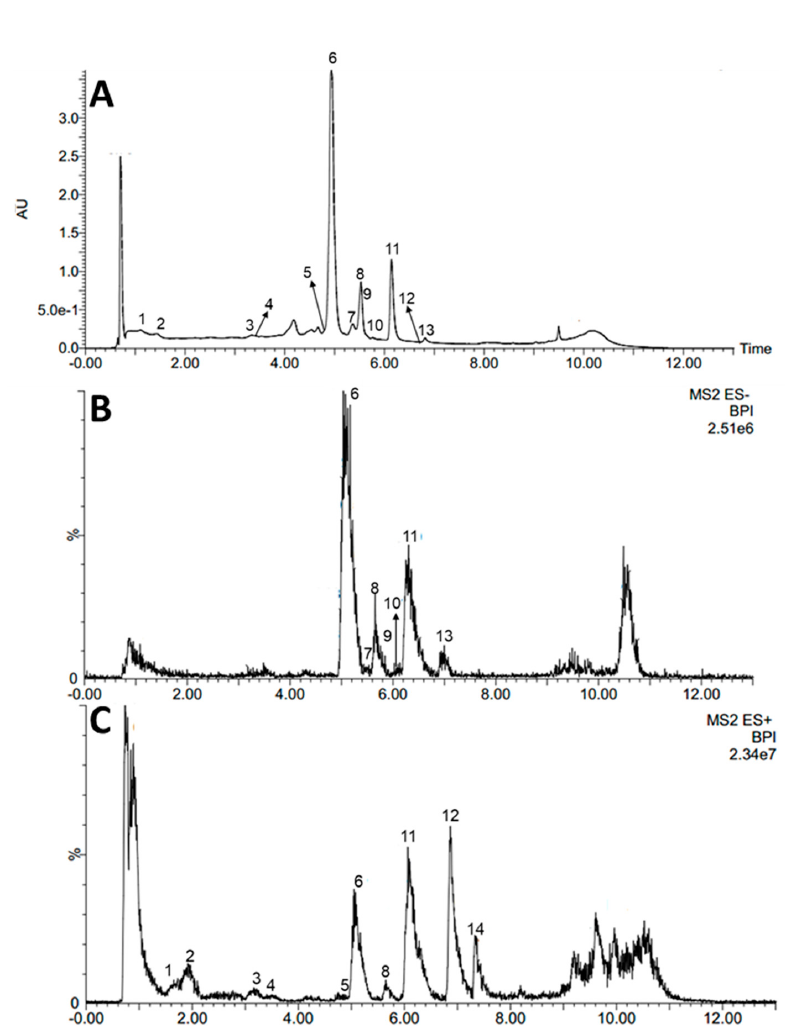
Figure 5. ( A ) UPLC-PDA chromatogram of the EtOH extract from S. odorifera optimized peels at 280 nm. ( B ) UPLC-ESI-MS chromatograms in the negative ( B ) and positive ( C ) ion mode of the EtOH optimized peel extract of S. odorifera .